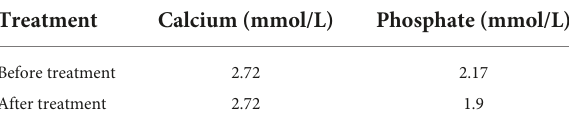
TABLE 1 The values of calcium and phosphate before and after bisphosphonate